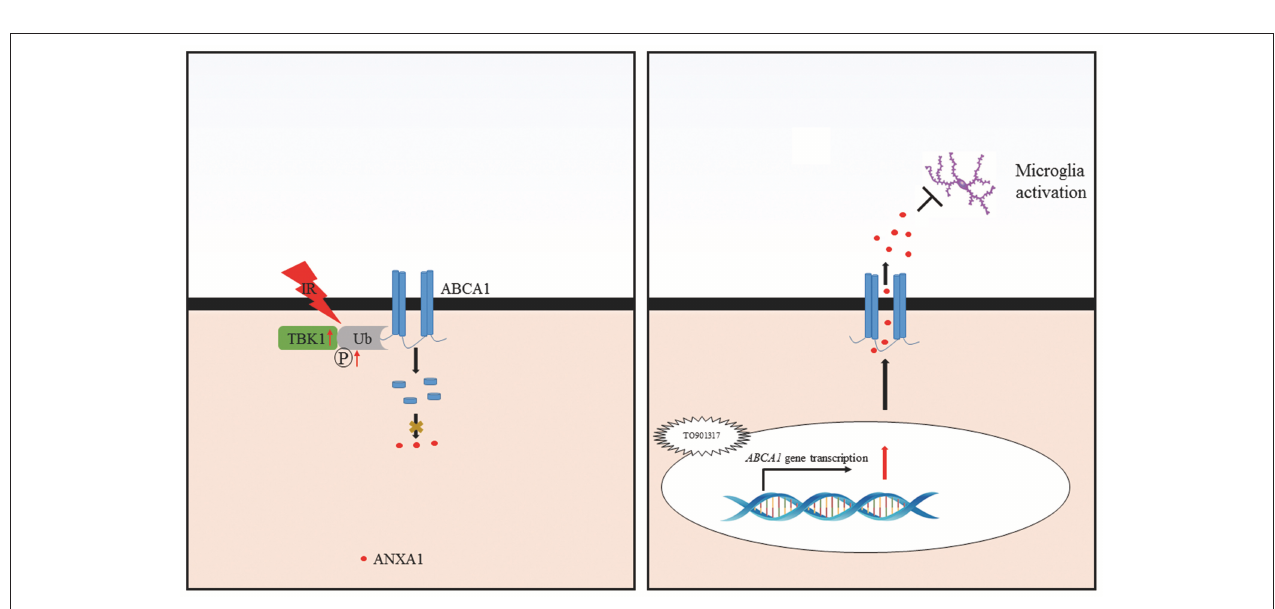
FIGURE 7 | Scale bar = 50 µ m. (B) Western blots showing the dose-dependent decrease in ABCA1 expression in HEK293 cells after TBK1 overexpression. (C) Statistical analysis of the data shown in (B) . The data of three independent experiments are expressed as the means ± S.D. * P < 0.05, one-way ANOVA with Bonferroni post hoc test vs. control. (D) Western blot showing Tbk1 siRNA knockdown reverse the reduction of ABCA1 which stimulated by LPS (1 µ g/mL). (E) Statistical analysis of the data shown in (D) . The data of three independent experiments are expressed as the means ± S.D. * P < 0.05, one-way ANOVA with Bonferroni post hoc test. (F) Western blot showing that Mg132 (10 µ M) can prevent in HEK293a decrease in ABCA1 levels induced by TBK1 overexpression. (G) Statistical analysis of the data shown in (F) . The data of three independent experiments are expressed as the means ± S.D. * P < 0.05, one-way ANOVA with